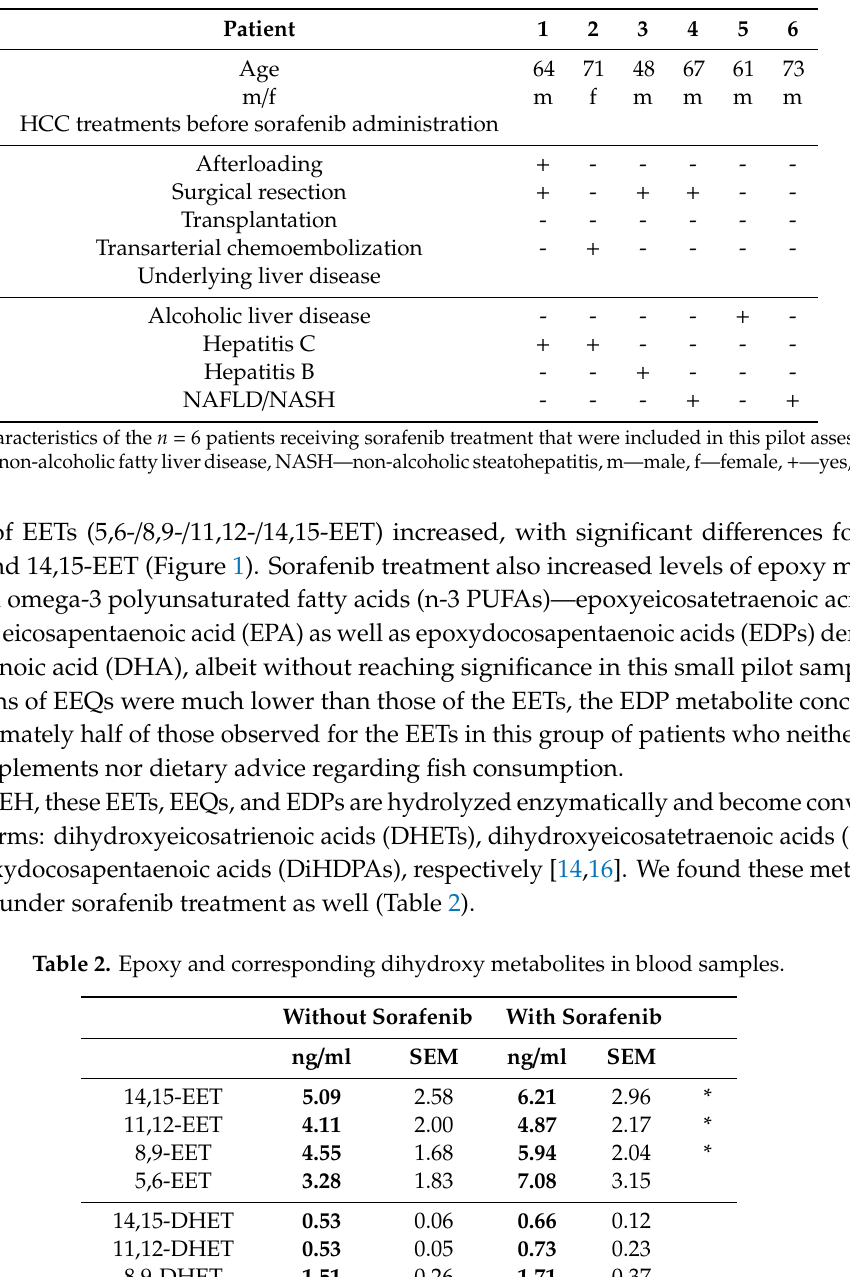
Table 1. Patient characteristics.